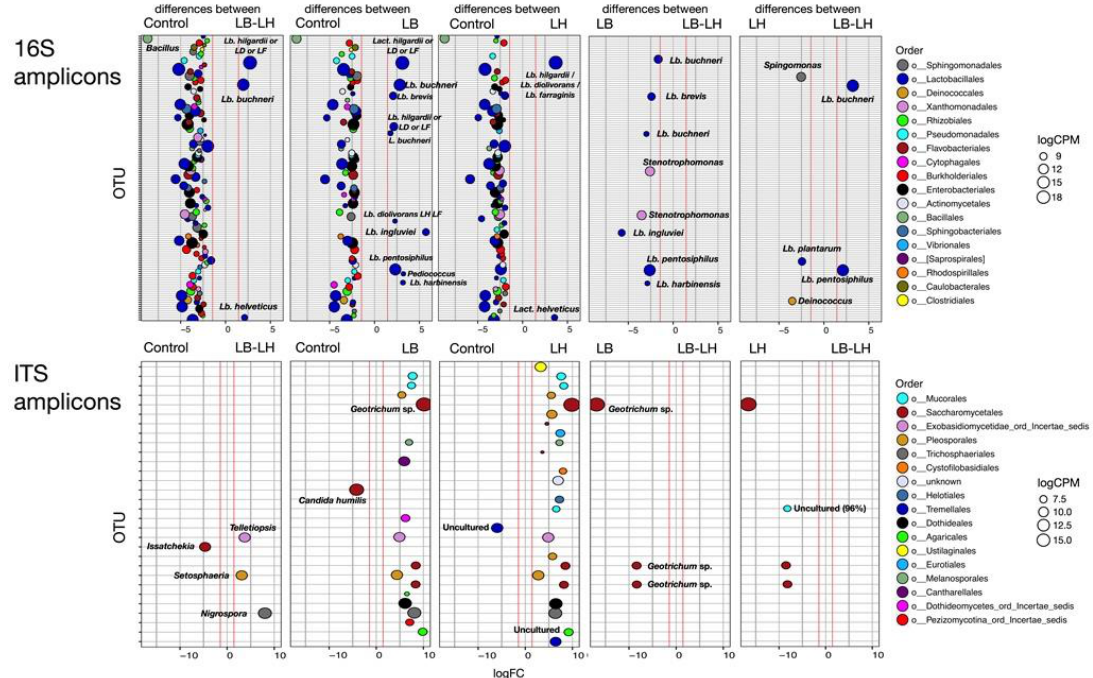
Figure 3. Contrast analysis of amplicon sequencing data of the samples after 64 days of ensiling using the EdgeR package from the 16S amplicons and the ITS amplicons. OTUs whose abundance di ff ered significantly between the Control and the three inoculation treatments or between the inoculation treatments themselves are shown. LogFC (fold changes) and logCPM (count per million) were used for the representation. Only OTUs with a logFC ≤ 1.5 (red line in each panel) and false discovery rate (FDR) value < 0.05 were considered as being di ff erentially abundant. Color coding is based on the taxonomic classification of individual OTUs. Taxonomic identification of the OTU a ffi liated as Lb. hilgardii could also be related to Lb. diolivorans or Lb. farraginis , according to the current database search